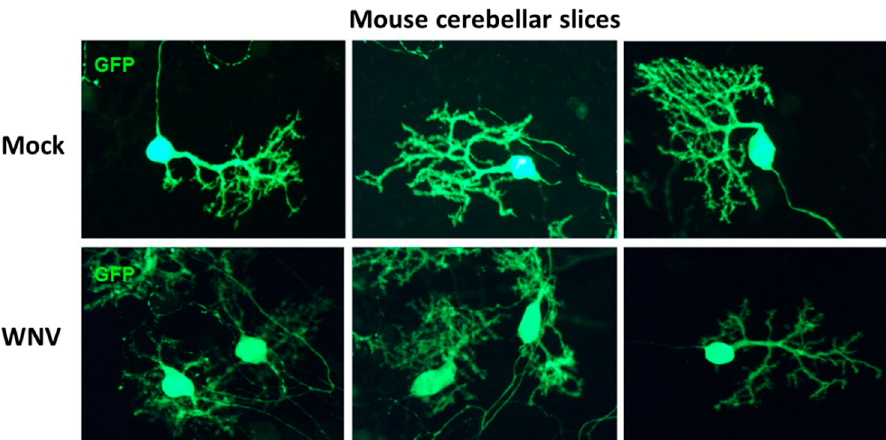
Figure 2. GFP immunofluorescence in mock- or WNV-treated (10 7 PFU) cerebellar slice cultures. Since GFP localization, especially in the dendritic spines of Purkinje cells, is heterogeneous [26], the slices were immunostained with GFP antibody to enhance visualization. Purkinje cells (PCs) in WNV-exposed cultures show shrunken or pruned dendritic arbors and reduced GFP immunostaining as compared to mock cultures. The total GFP immunoreactive area of these images was quantified with ImageJ. The total area of WNV-treated PCs was significantly less (3736 ± 525.2, n = 5) than mock-treated PCs (9330 ± 1226, n = 3). The data are presented as mean ± SEM and p < 0.003.